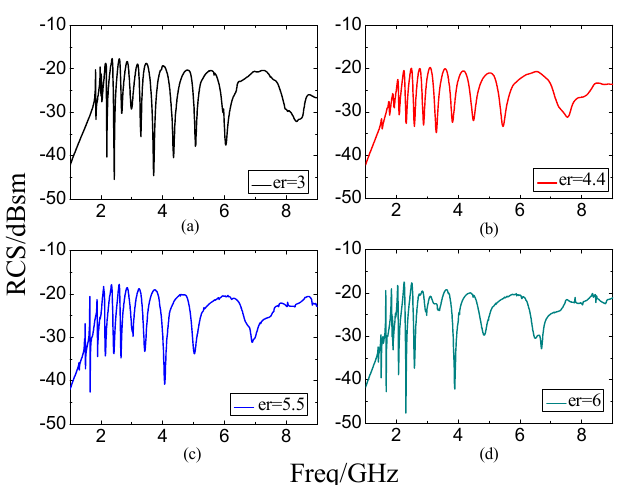
Figure 17. The simulation spectra of the twelve Rectangular Slot Rings when the FR4 substrate has different relative dielectric constants ( ε r ), respectively. ( a ) ε r =3, ( b ) ε r =4.4, ( c ) ε r =5.5, (d) ε r =6. The encoding capacity is increased by adding the concentric rectangular slot rings.